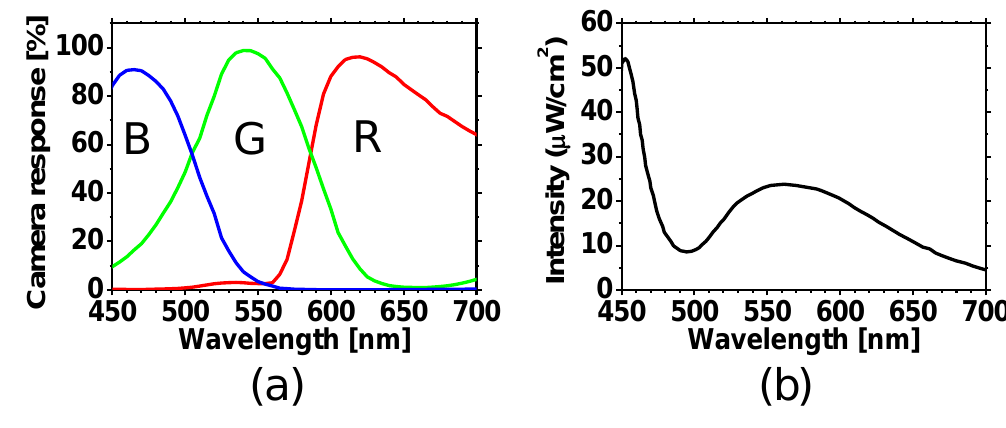
Figure 2. Spectral profiles for ( a ) the RGB-responses of camera and ( b ) the intensity of illuminant.